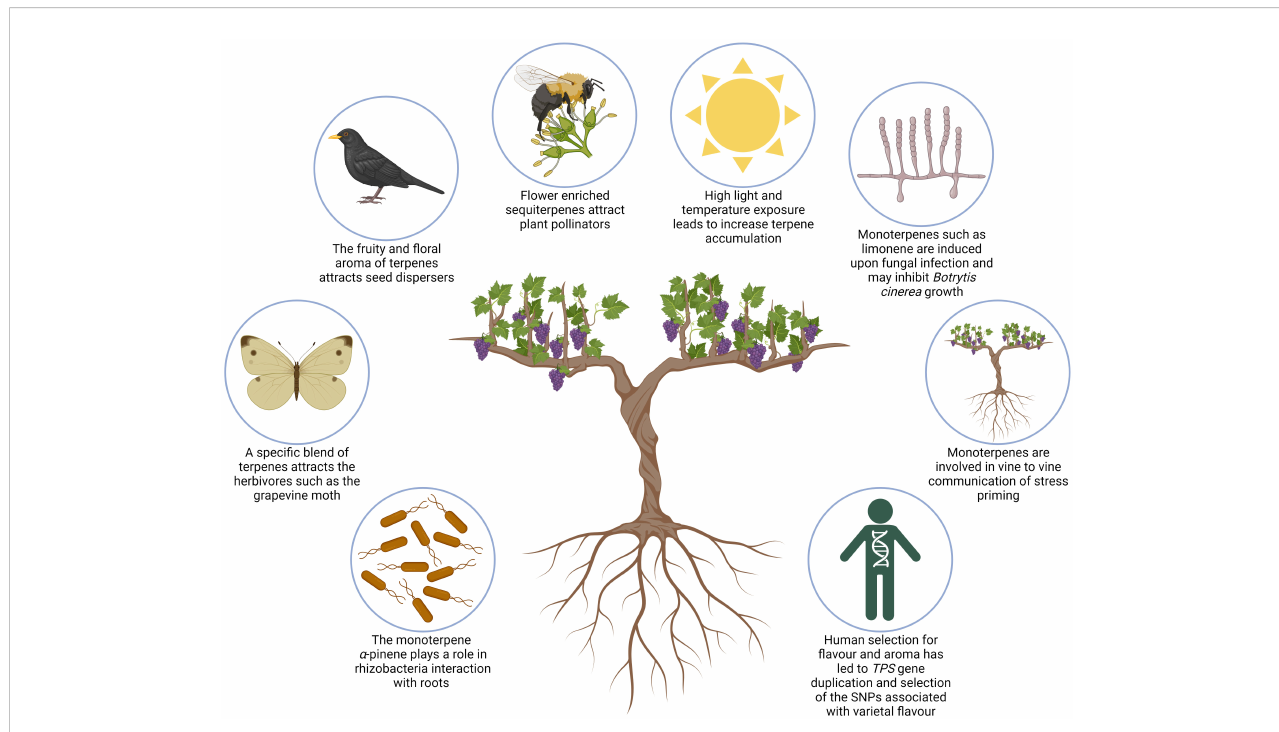
FIGURE 4 Schematic illustrating ecophysiological roles of mono- and sesquiterpenes in Grapevine. Clockwise, from bottom left, images illustrate the following: monoterpenes have been shown to play a unique function in grapevine roots and their interaction with mutualistic rhizobacteria; the European grapevine moth pest is attracted by a mix of VOCs containing sesquiterpenes; a blend of terpenes is involved in attraction of agents of seed dispersal; sesquiterpenes are the most abundant specialised terpene in grapevine buds and fl owers and are involved in attraction of pollinators; light exposure, high temperatures, and UV-B radiation can all increase terpene accumulation in grape berries; several monoterpenes have been found to inhibit fungal growth of Botrytis cinerea and Plasmopara viticola ; monoterpenes such as a -pinene are suggested to play a role in vine-to-tine communication and priming of stress; human selection of cultivars has led to gene duplication of TPSs and the selection of SNPs associated with varietal fl